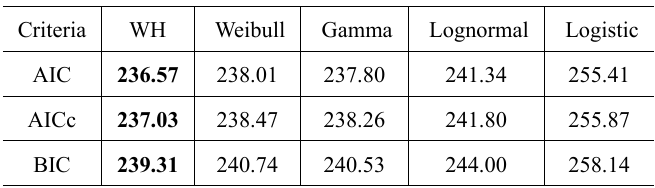
Results of AIC, AICc and BIC criteria for all fitted distributions considering the dataset related to the agricultural machine’s components electrical problems. Criteria